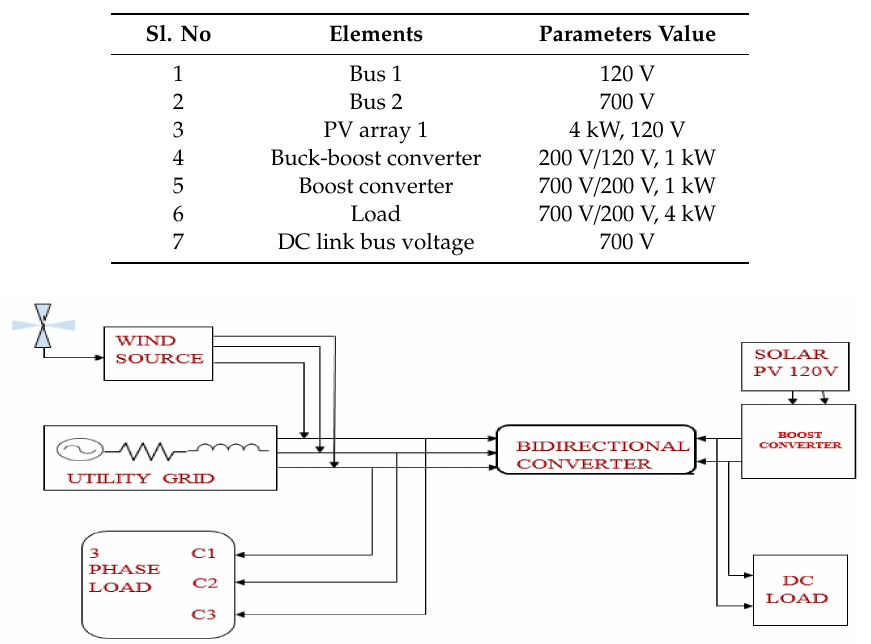
Table 2. DC network parameters.